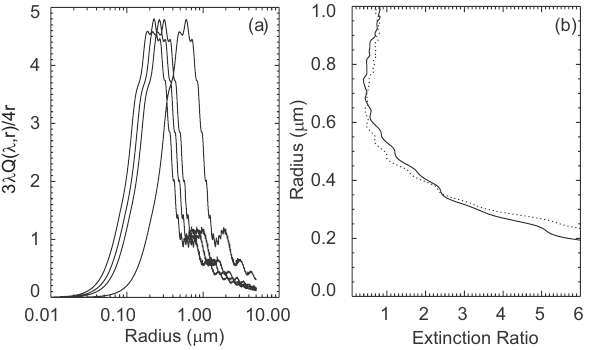
Fig. 2. (a) shows the Mie extinction kernels for the 525 and 1020nm SAGE II aerosol extinction coefficient measurements for sulfate aerosol at stratospheric temperatures. (b) shows the relationship be- tween the ratio of the 525 and 1020nm extinction kernels and par- ticle